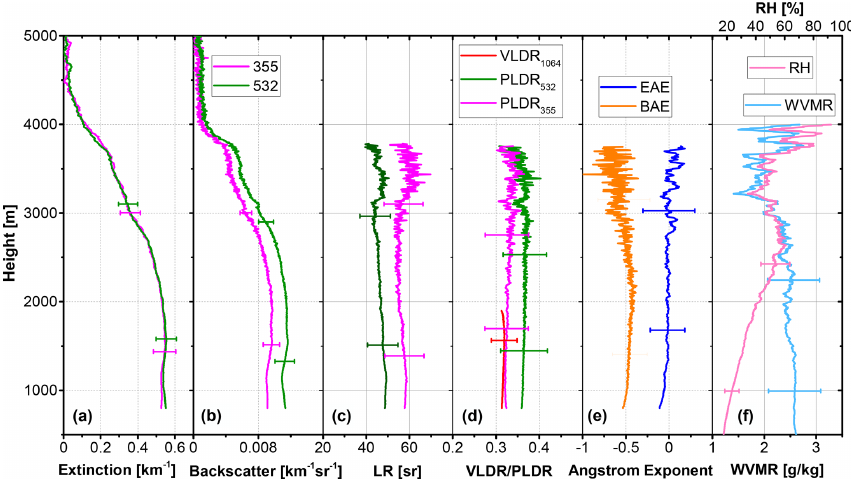
Figure 6. Case 1: lidar-derived parameters at 17:00–22:00UTC, 9 April 2019. (a) Extinction coefficient, (b) backscattering coefficient,